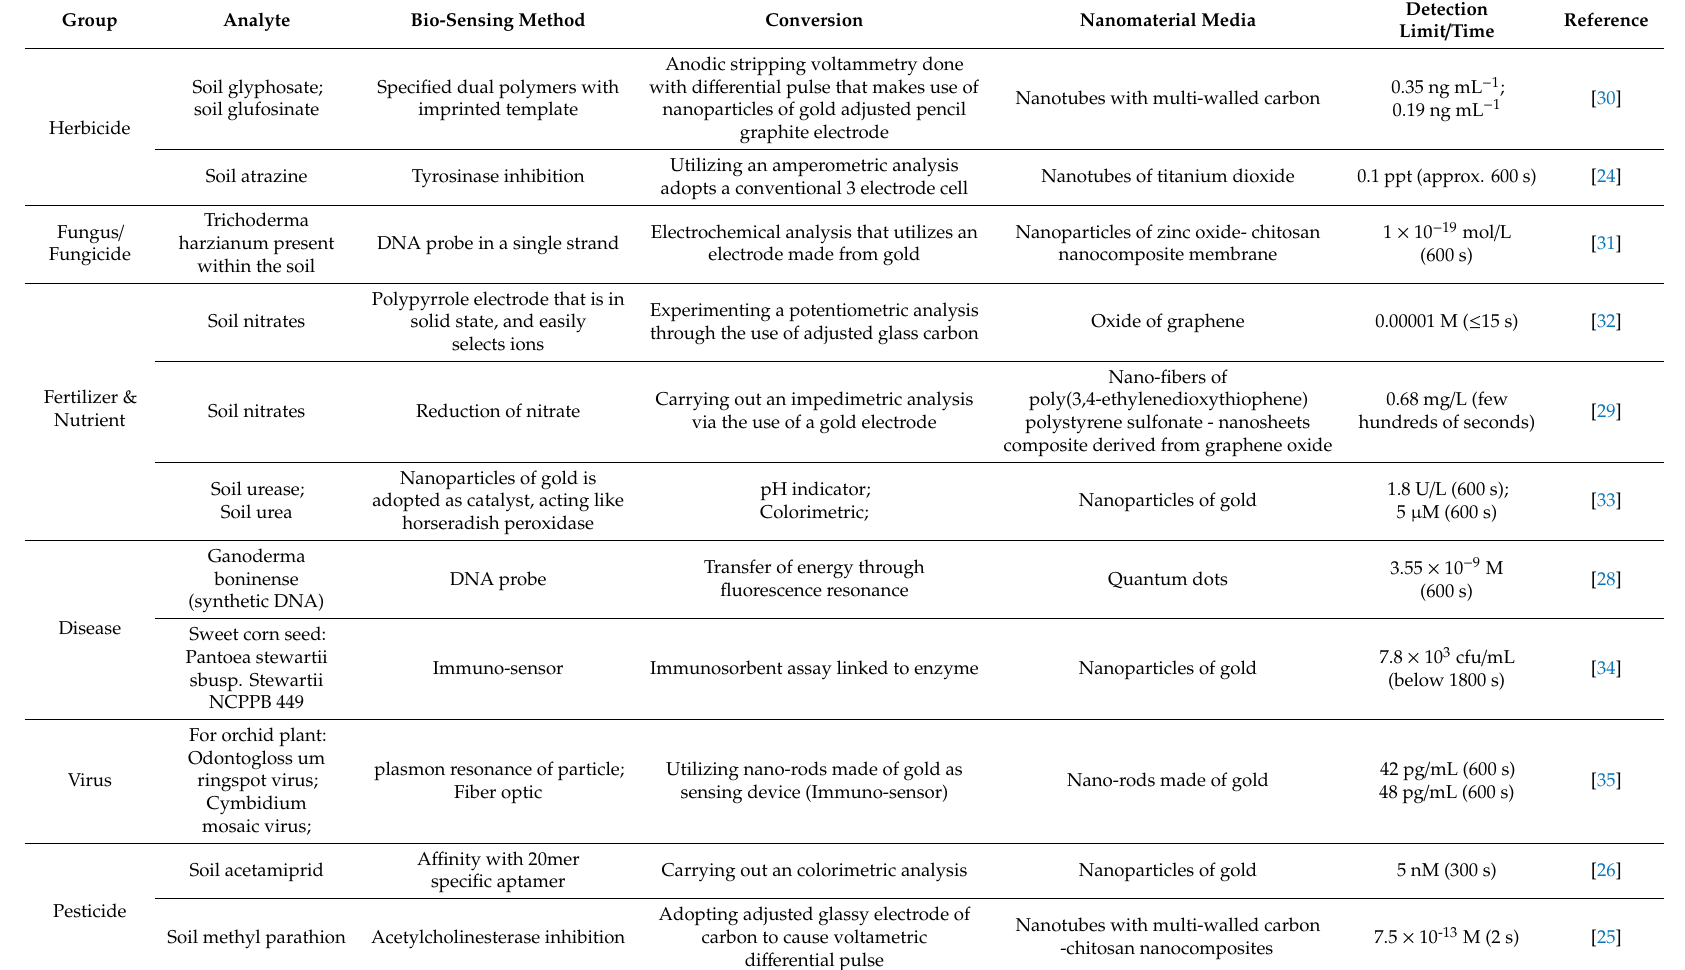
Table 1. Summary of some biological sensing techniques for soils and plants (Adapted from Antonacci